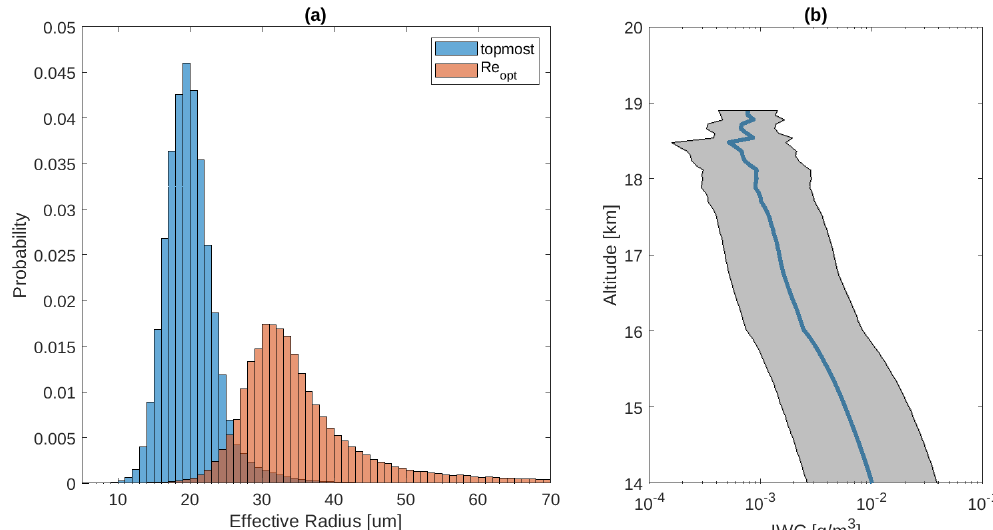
Figure 2. Cloud statistics based on 98293 overshooting deep convective samples from the DARDAR-Cloud dataset. The samples are within 1000km of a tropical cyclone center. (a) Histograms of the effective radius (µm) of cloud ice particles at the topmost layer (blue) and the effective radius for representing vertically uniform optical properties ( R e , opt , red). (b) Mean IWC (blue curve) and SD of the IWC (gray